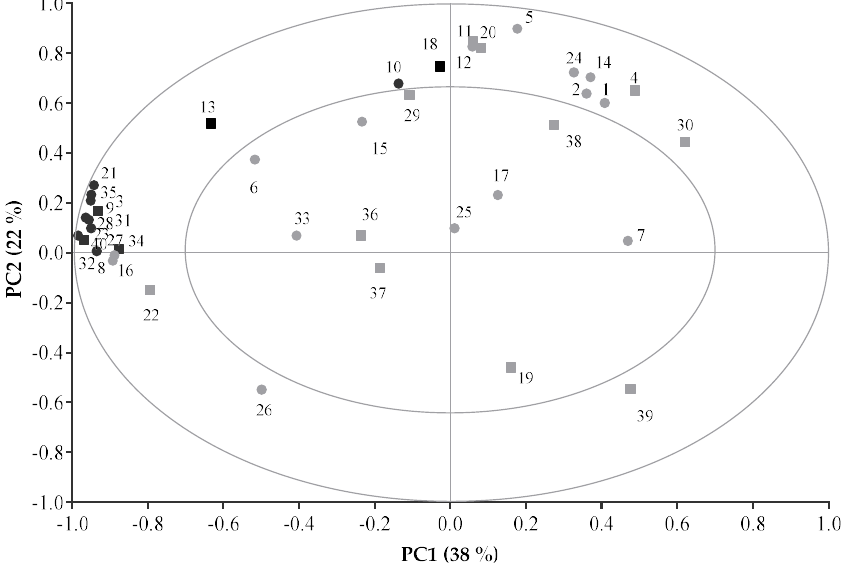
Figure 5. Correlation loading plot of the PCA analysis with 9 important mVOCs and 5 non-mVOCs (in bold) relating to the separation of the CA3 pellet treatment ( • & • mVOCs; (cid:121) & (cid:121) non-mVOCs). The numbers correspond to the compound names as in Figure 6. The outer ellipse indicates 100% explained variance. The inner ellipse indicates 50% of explained